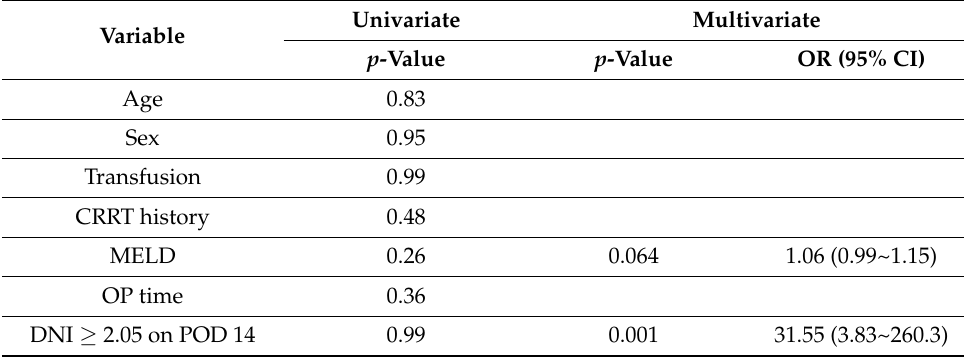
Table 3. Univariate and multivariate analyses including other factors showed that DNI ≥ 2.05 on POD 14 was the only mortality predictor ( p =